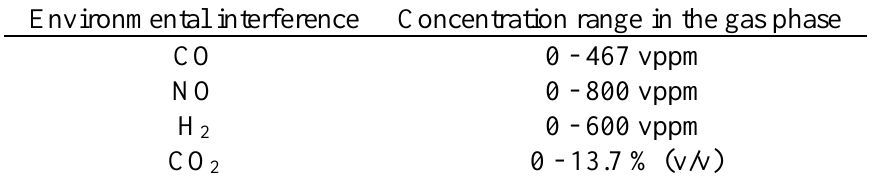
Table 4 . Concentration range for the tested environmental inorganic